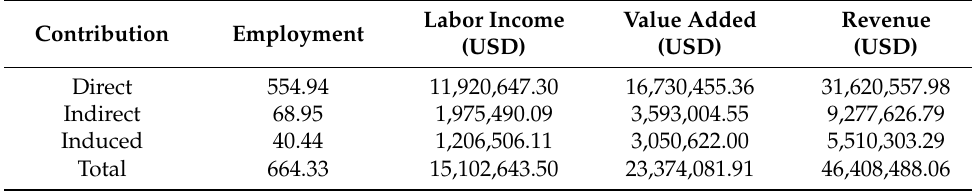
Table A20. Total Contribution of Apalachicola to Franklin County (Annual).